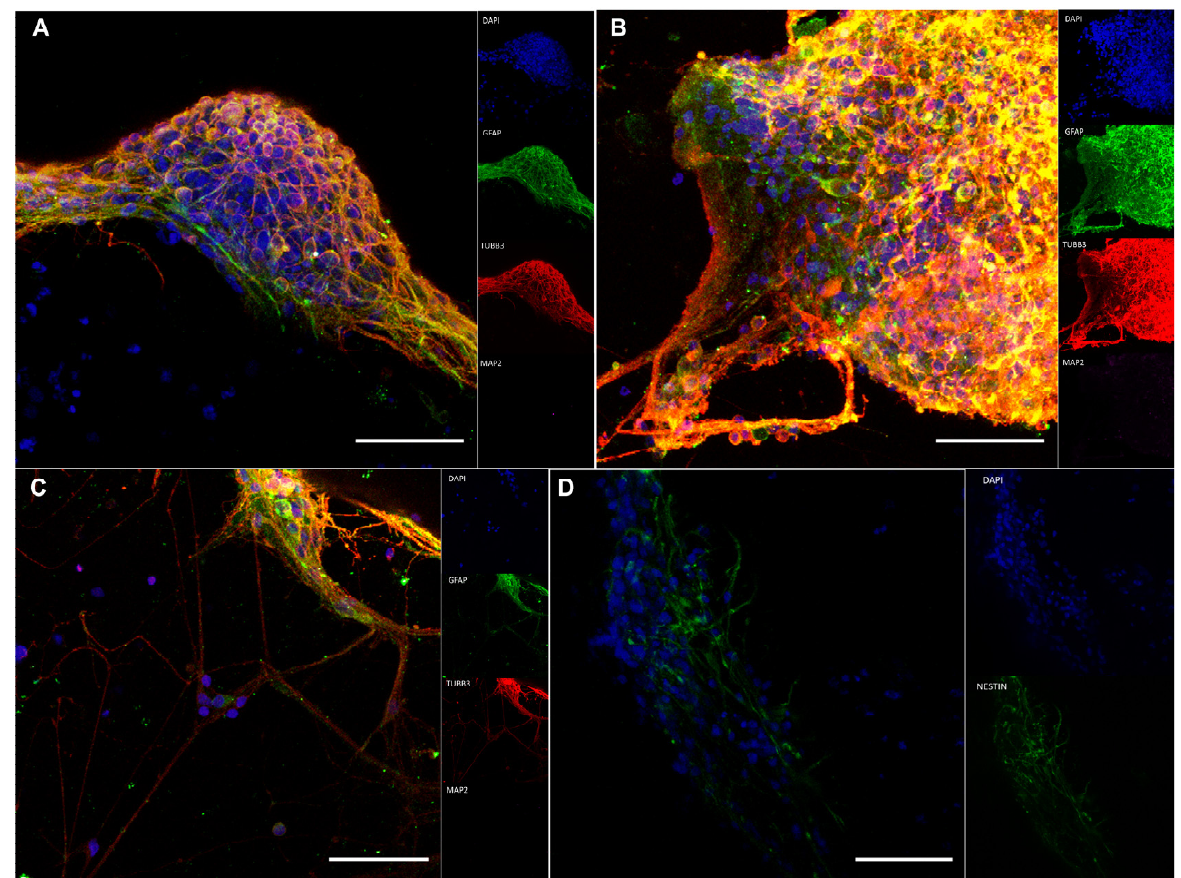
Figure 6. Bioprinted hNPCs successfully differentiated in immature neurons. Immunofluorescence for GFAP, TUBB3 and MAP2 markers in bioprinted hNPCs on neural maturation media at 28 dpp ( A , B ). Cells outside the clusters that are marked strongly for TUBB3 rather than GFAP ( C ). Immunofluorescence for NESTIN in bioprinted hNPCs on neural maturation media at 28 dpp ( D ). Scale bar = 50 μ m. dpp = days post-printing.